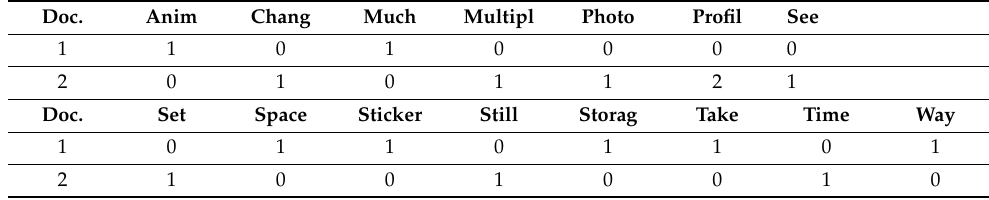
Table 8. The results of BoW on sample reviews.